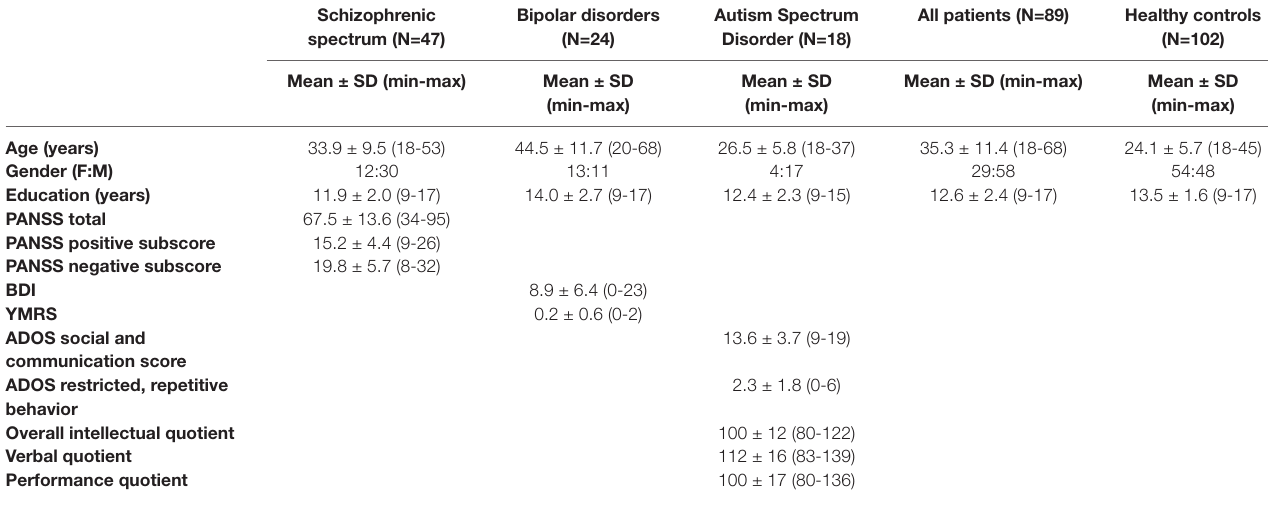
TABle 1 | Participants' characteristics (mean ± standard deviation;